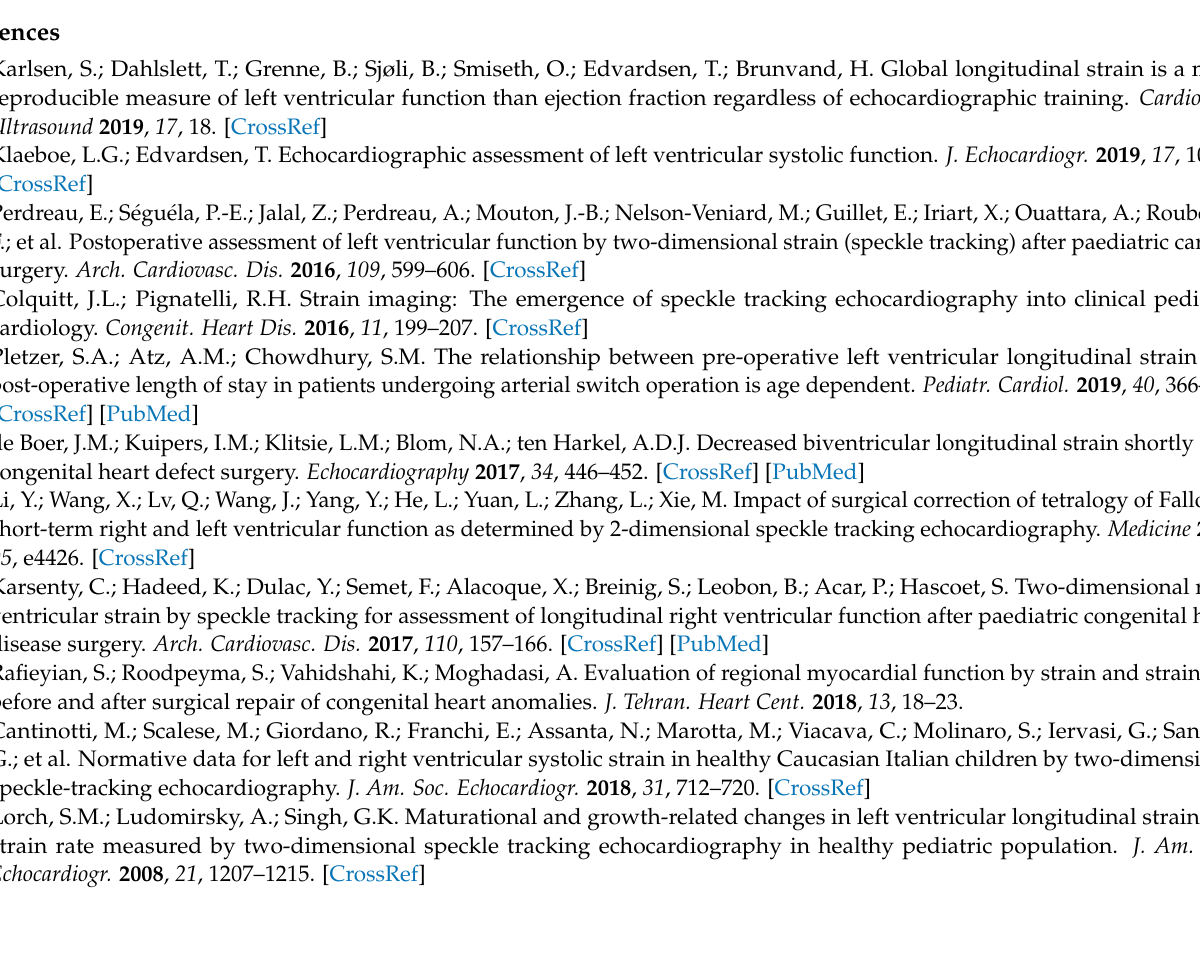
Comparison Inotropes vs. No